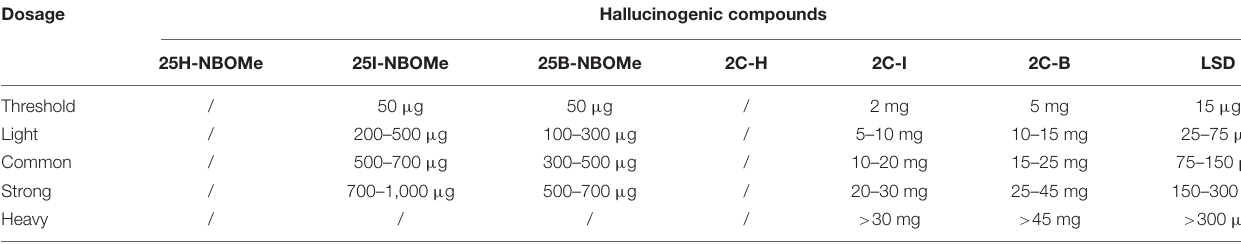
TABLE 2 | Different duration of effects of hallucinogen compounds